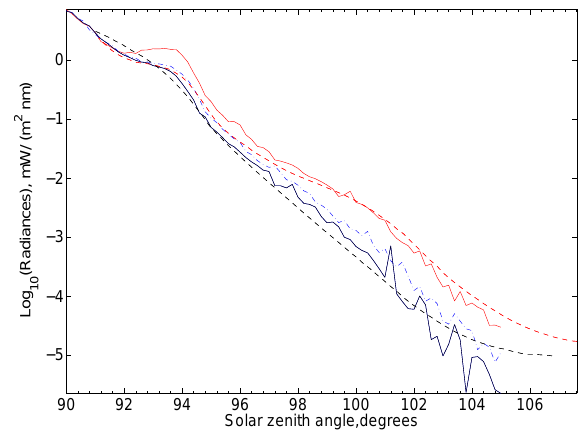
Fig. 14. The measured pre-Pinatubo (black dashed line) and post- Pinatubo (8 November 1991, red dashed line) twilight curves. Solid red, dash-dotted blue and solid black are curves modelled using cor- responding aerosol profiles presented in Fig.